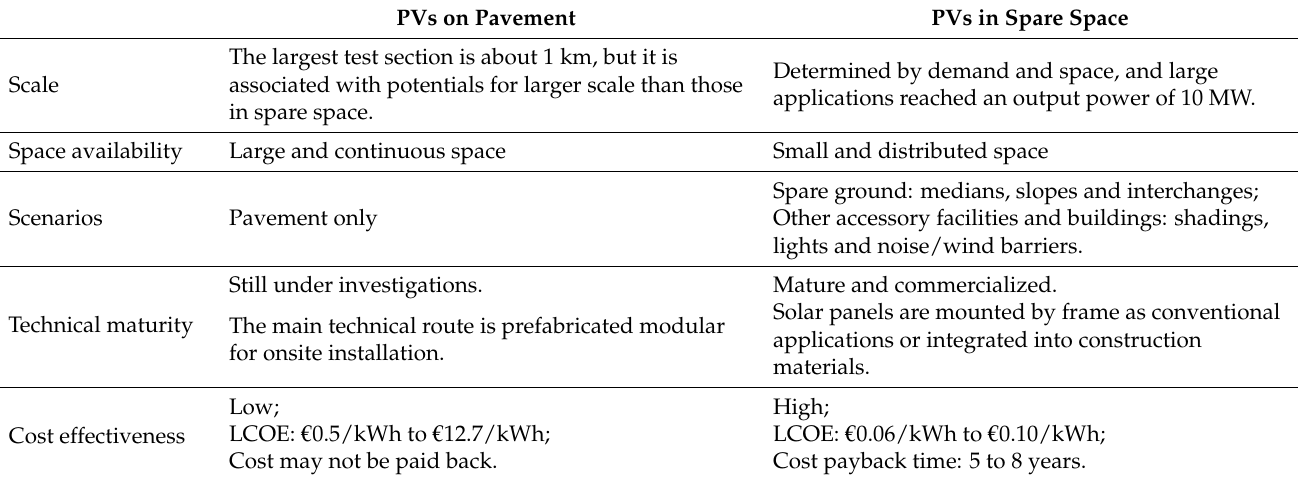
Table 3. Compassion between PV facilities in spare space and pavement. PVs on Pavement PVs in Spare